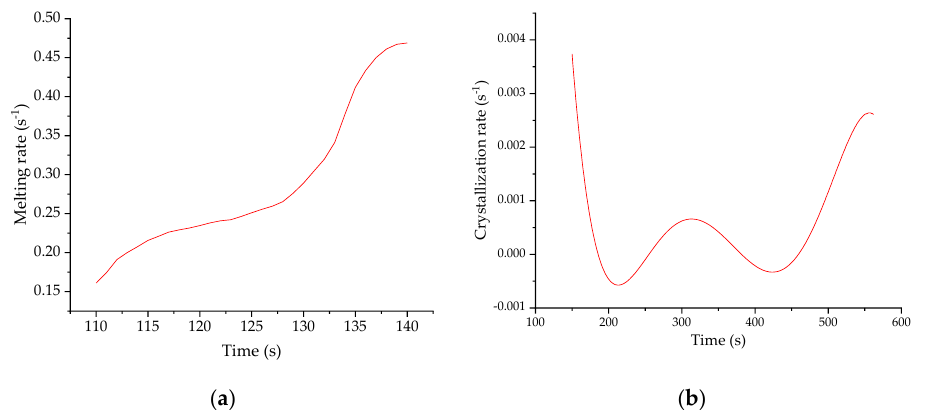
Figure 12. Curves of melting rate and crystallization rate. ( a , b ) are the curves corresponding to melting and crystallization, respectively.